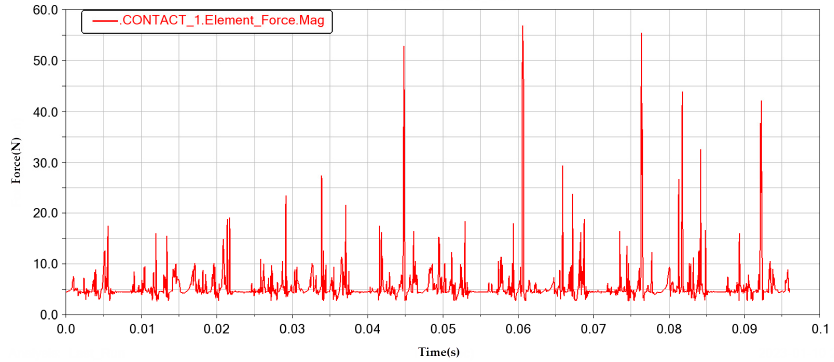
Figure 23. First piston pin force curve.